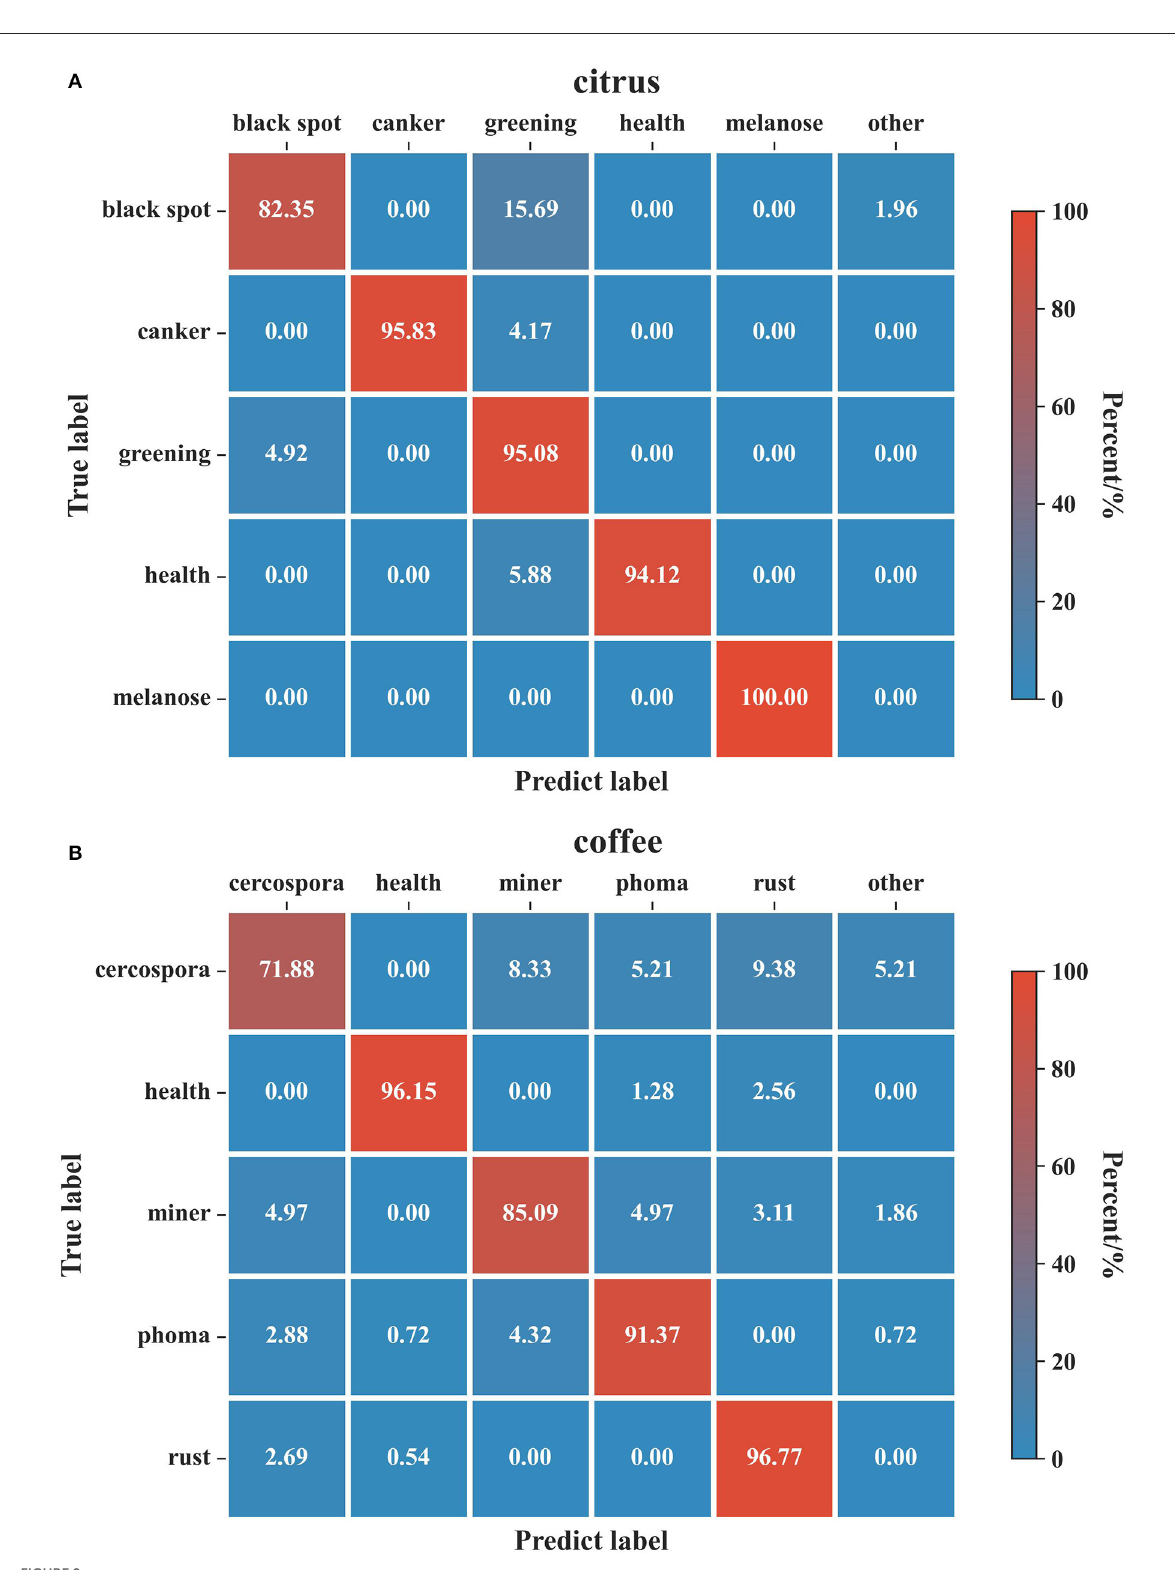
FIGURE9 Confusion matrix for the evaluation results on the citrus and coffee datasets. (A) Citrus dataset. (B) Coffee dataset. The columns of the confusion matrix indicate the predicted classes and the rows correspond to the true classes. The diagonal represents the ratio of true positives whereas the rest of the matrix corresponds to false negatives. A detection result whose probability is less than the threshold is set as the class: